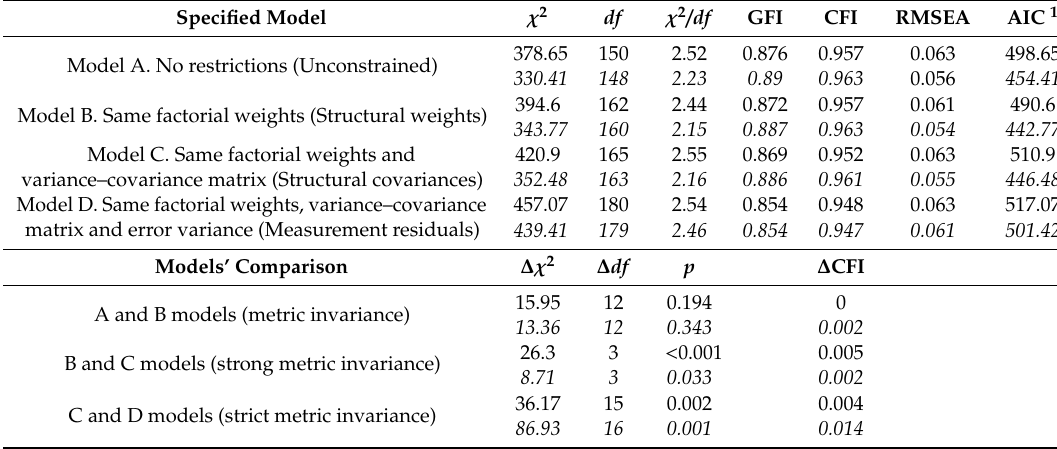
Table 4. Goodness of fit indexes according to origin.